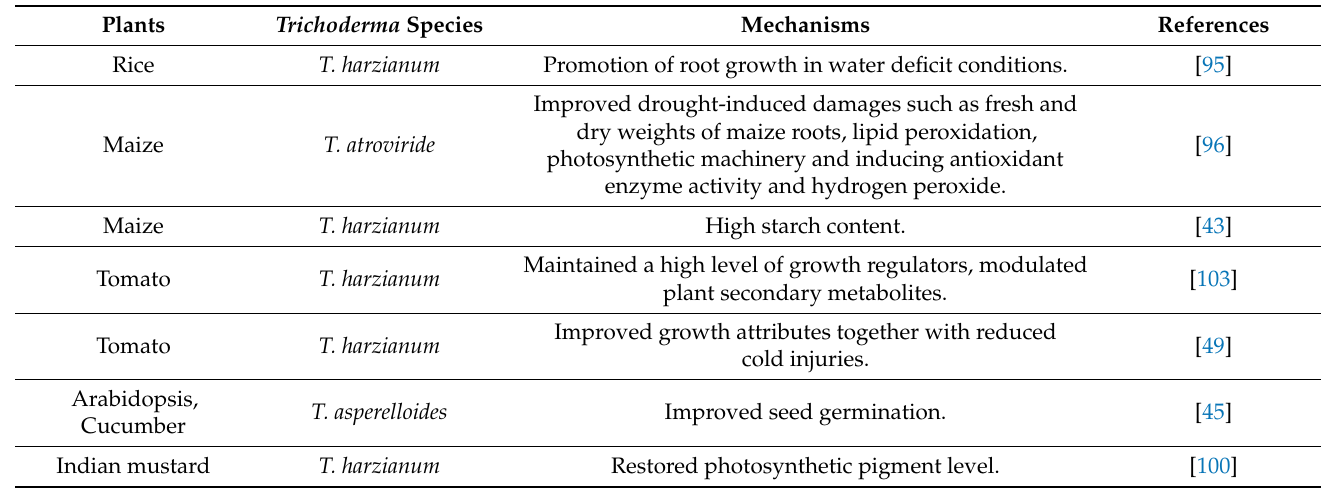
Table 3. Trichoderma and their abiotic stress regulation